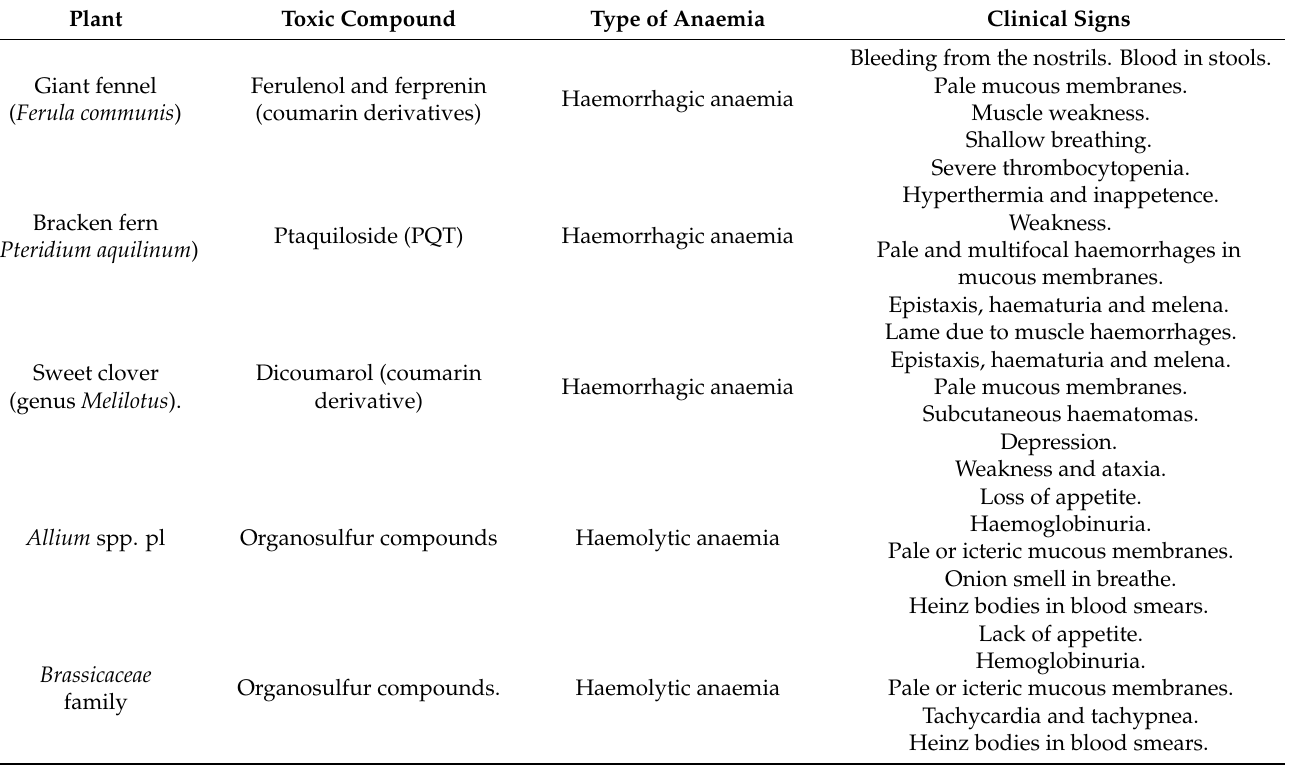
Table 1. Clinical signs, toxic compounds and type of anaemia associated to each plant